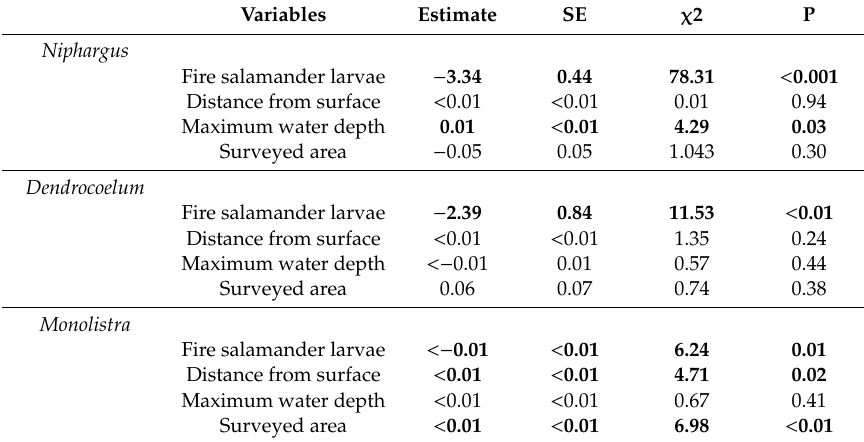
Figure 3. Boxplots of relationships between the occurrence of fire salamander larvae and abundance of the stygobiont target taxa: ( a ) amphipods of the genus Niphargus ; ( b ) planarians of the genus Dendrocoelum ; ( c ) isopods of the genus Monolistra . Table 1. Results of the likelihood ratio test on generalized linear mixed models (GLMMs) assessing the relationship between the presence of fire salamander larvae and environmental variables with the abundance of the three target stygobiont taxa. Significant relationships are in bold.